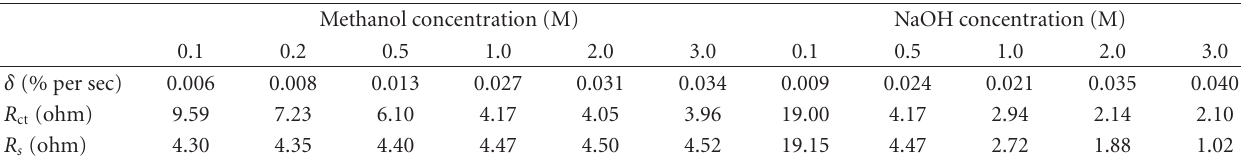
Table 1: Variation of long-term poisoning rate ( δ ), charge transfer resistance ( R ct ), and solution resistance ( R s ) for methanol oxidation on Pt-Pd/C electrode at various methanol and NaOH concentrations at − 160 mV.